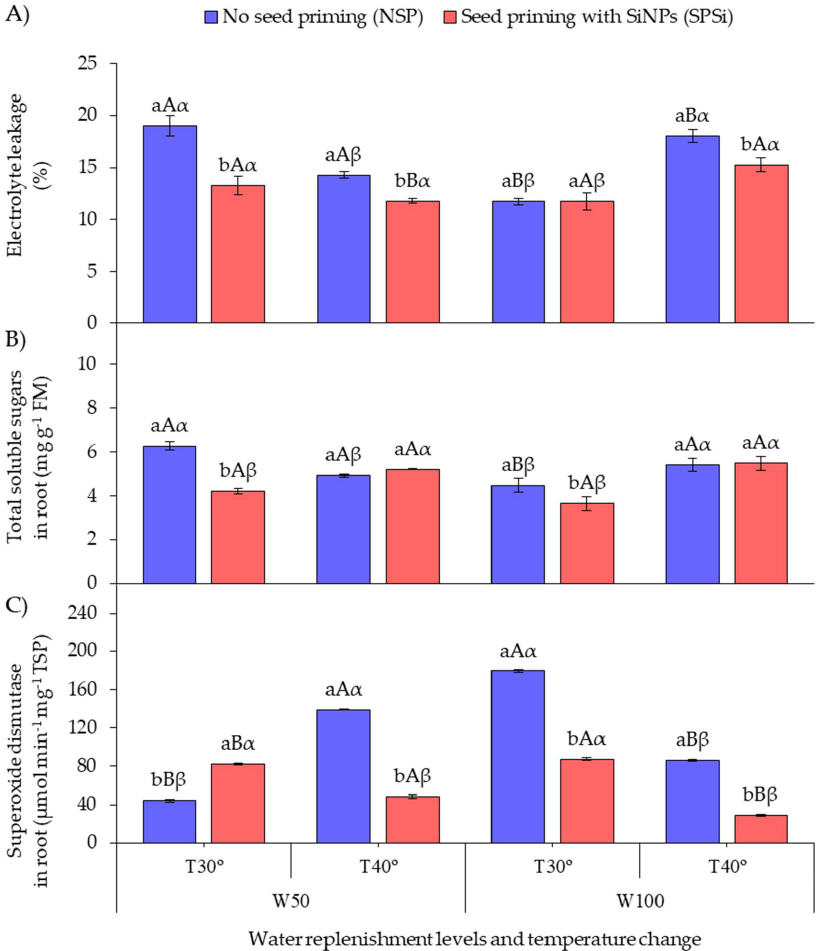
Figure 2. Electrolyte leakage ( A ), total soluble sugars in roots ( B ), and superoxide dismutase activity in roots ( C ) as a function of soil water replenishment levels and temperature change in Moringa oleifera . Means followed by the same lowercase letters (a, and b) for seed priming, uppercase letters (A, and B) for soil water replenishment, and Greek letters (α, and β) for temperature change do not differ ( p > 0.05) by Student’s t -test. FM, fresh mass; TSP, total soluble proteins.